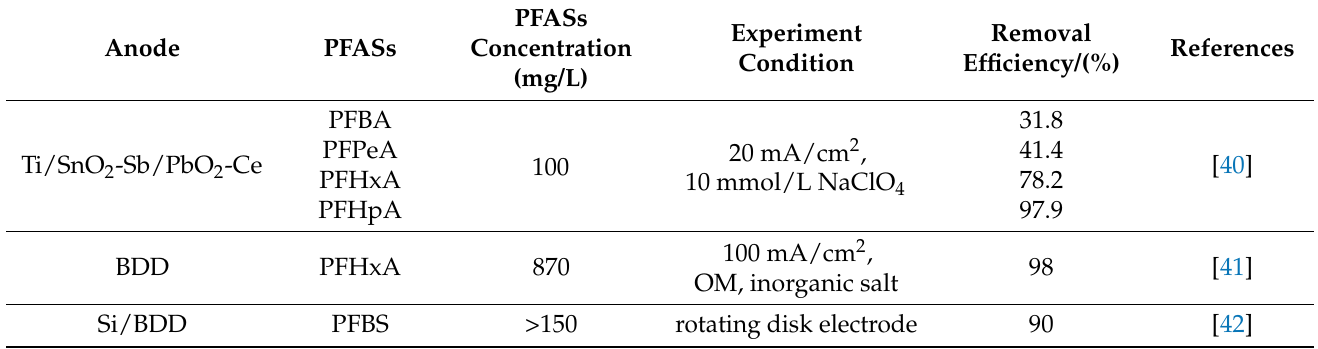
Table 3. Removal efficiency of short-chain PFASs by different electrode